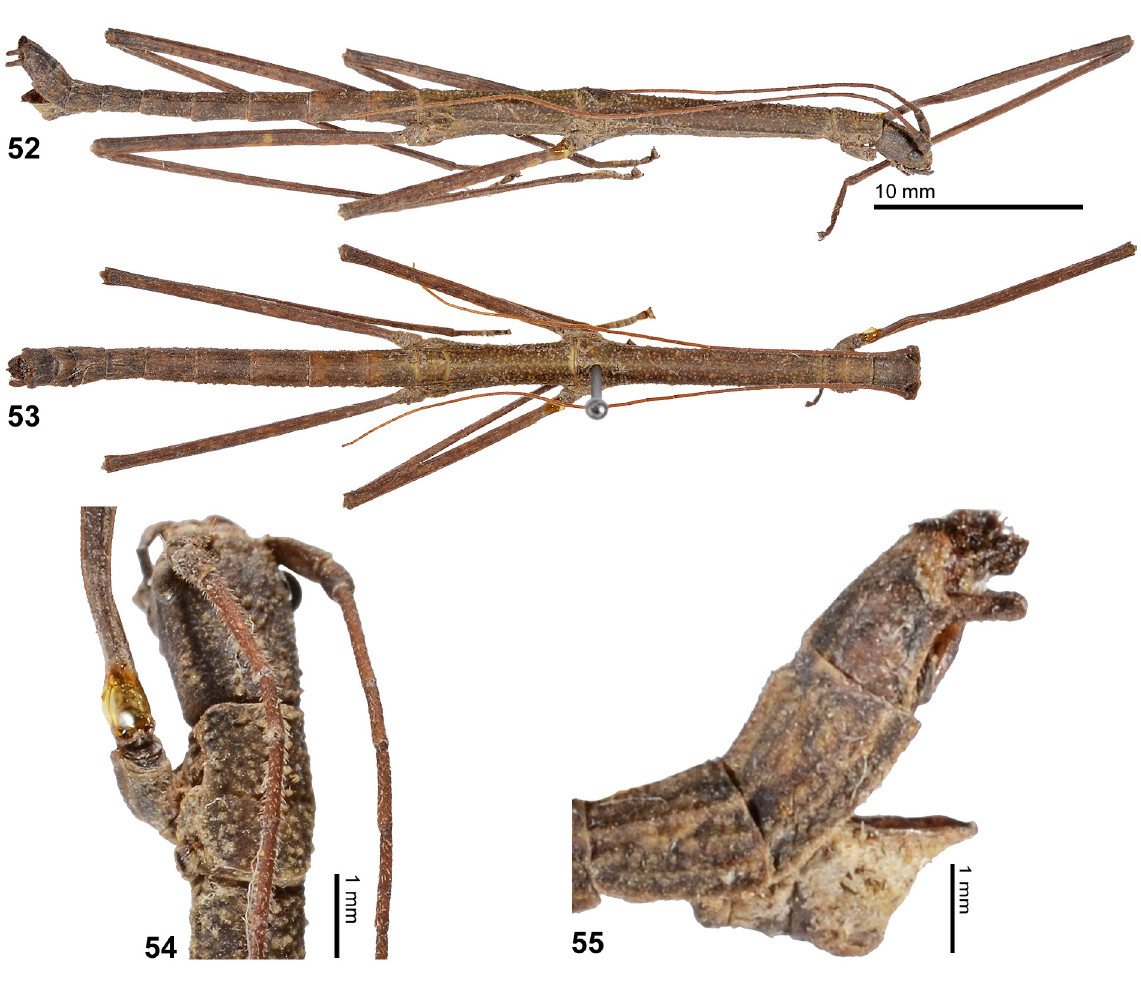
Figs 52–55. Lobolibethra verruculosa sp. nov. 52 . ♂, HT: lateral view (ANSP). 53 . ♂, HT: dorsal view (ANSP). 54 . ♂, HT: head and pronotum in dorsal view (ANSP). 55 . ♂, HT: apex of abdomen in lateral view